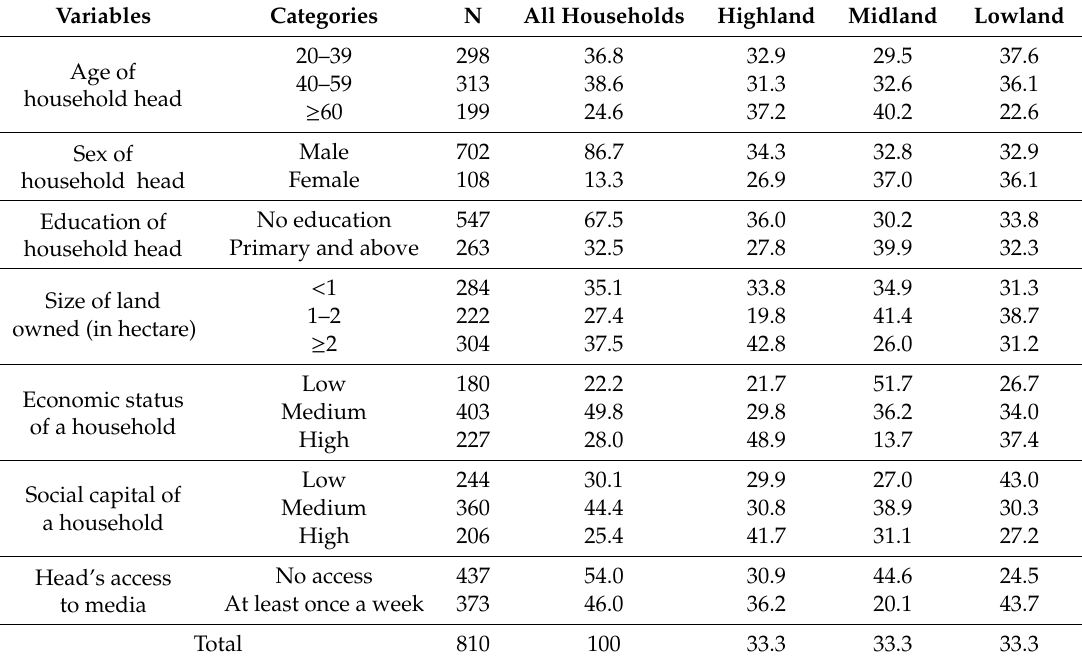
Table 5. Percentage distribution of households’ demographic and socio-economic characteristics by agro-ecological